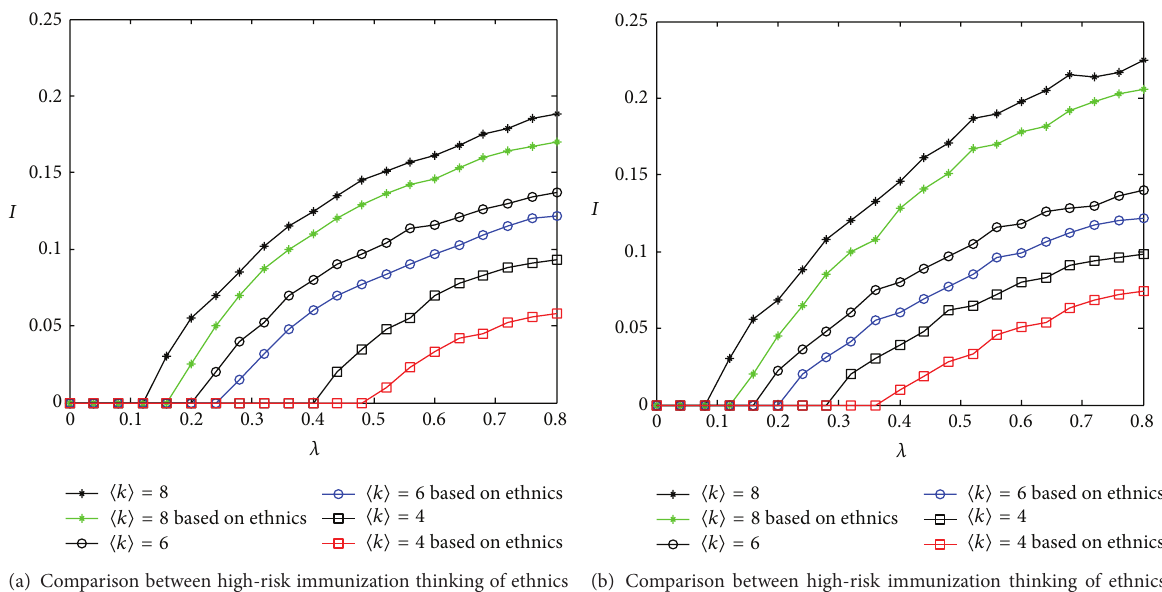
⟨ k⟩ = 4 based on ethnics (a) Comparison between high-risk immunization thinking of ethnics (b) Comparison between high-risk immunization thinking of ethnics and the contrast with different average degrees and the contrast with different average degrees Figure3:Atafixedvaccinatingrate 𝛿 = 0.3 ,thecomputersimulationsofSIRSmodelwithhigh-riskimmunizationonBAscale-freenetworks. = 𝜁 = 𝜁 = 0.7 . (a) When 𝑁 = 1000 , the variation of infected density 𝐼(𝜆) as a function of 𝜆 . (b) When 𝑁 = 3000 , the changing of 𝜁 𝐴𝐵 𝐵𝐶 𝐴𝐶 infected density 𝐼(𝜆) as a function of 𝜆 .